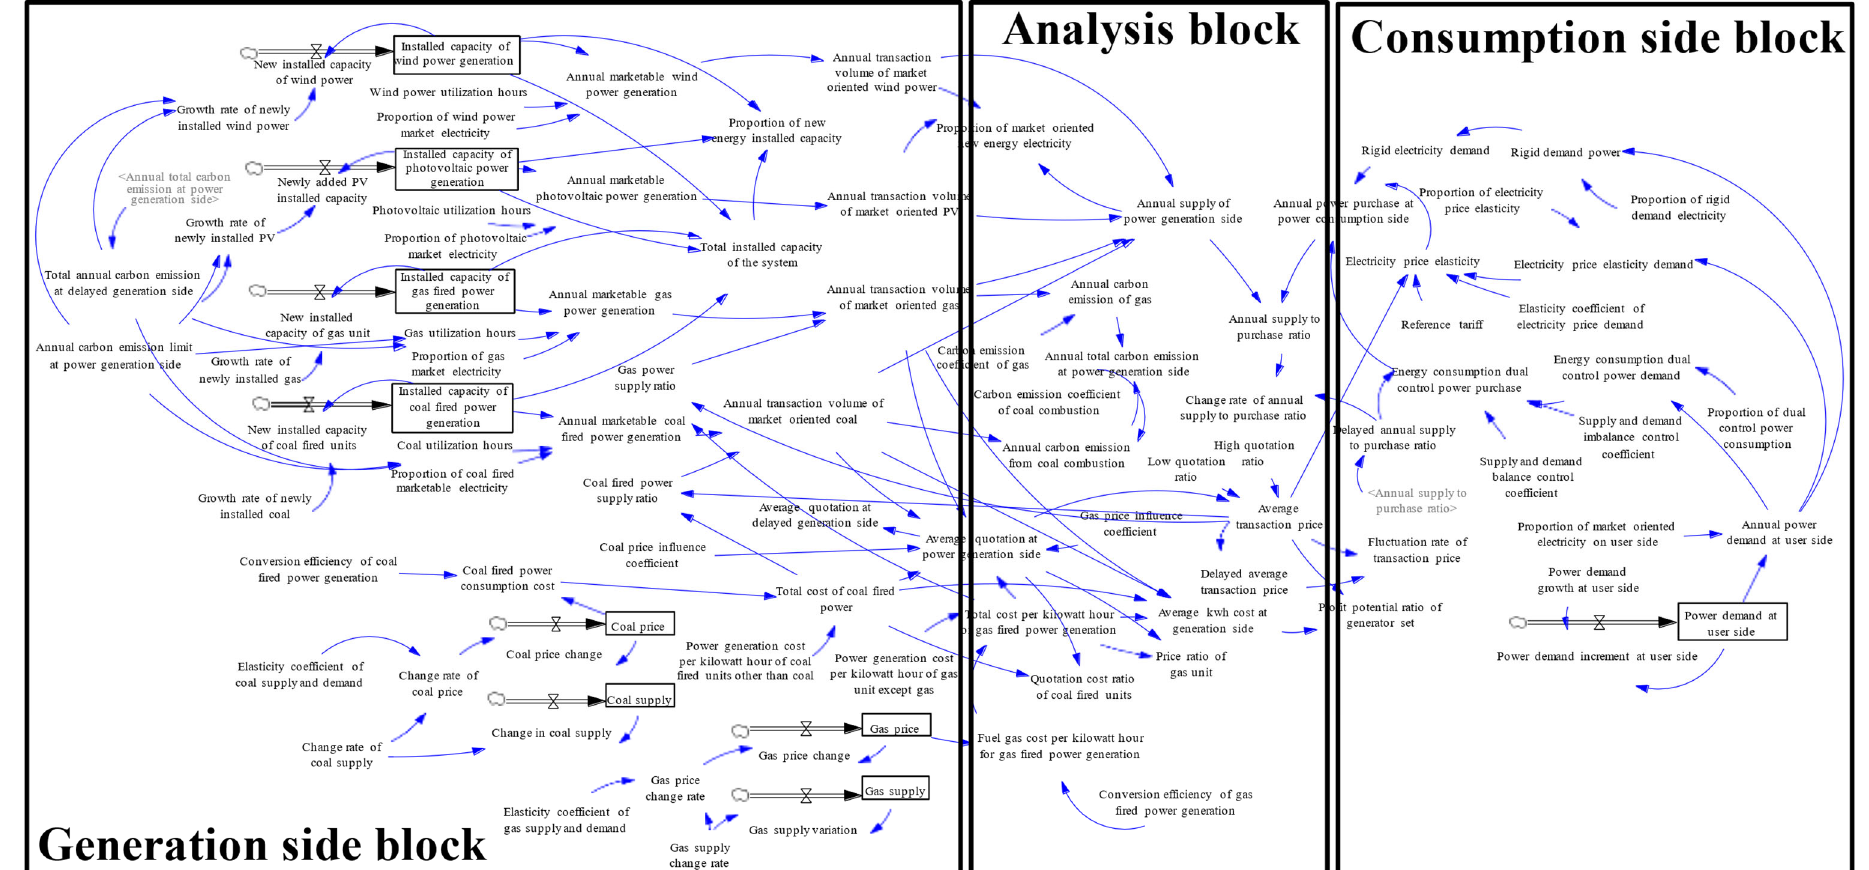
Figure 1. Power market operation situation system dynamics model stock flow diagram.